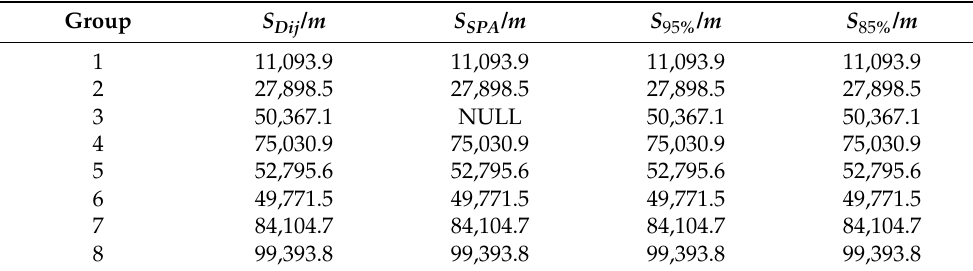
Table 2. Comparison of the shortest path length between Dijkstra algorithm and the three restricted search area algorithms.